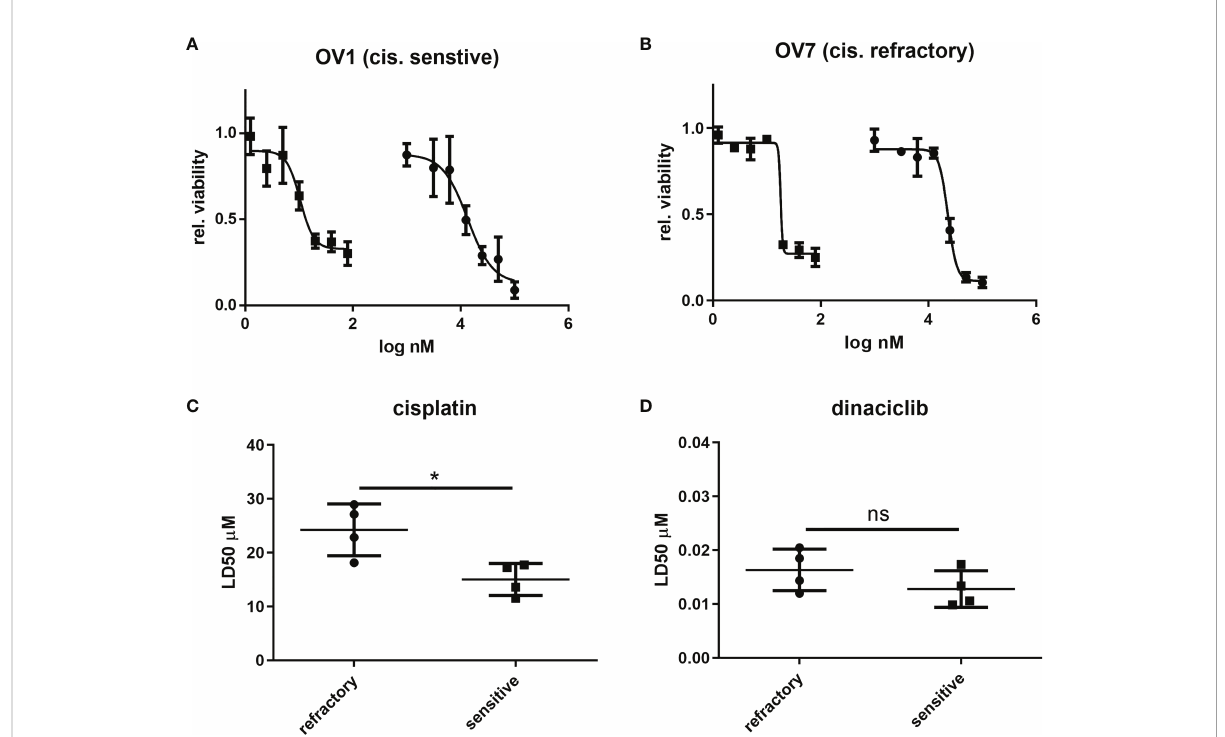
FIGURE 4 Dinaciclib is equally ef fi cacious in platinum sensitive and refractory patient derived tumour cells. Primary cells were isolated from tumour samples and classi fi ed as platinum sensitive (OV1-4), or refractory (OV5-8) based on clinical history (see Table 1). Dose response experiments with cisplatin and dinaciclib were performed on the isolated cells with representative curves from platinum sensitive sample and platinum refractory samples shown in (A) and (B) respectively. Viability is normalised to media controls. LD50s derived from these experiments were compared between platinum sensitive and refractory groups and are shown for cisplatin in (C) and dinaciclib in (D) . Data are expressed as mean of three independent experiments with error bars representing standard deviation. Statistical signi fi cance was evaluated using the signi fi cance was calculated using the unpaired t-test. *p value < 0.05, ns, not signi fi